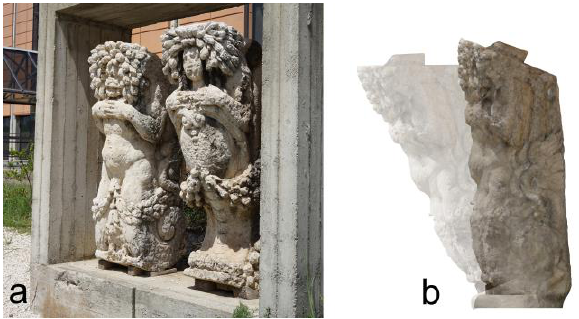
Figure 14 . The corbels in the Regional Museum of